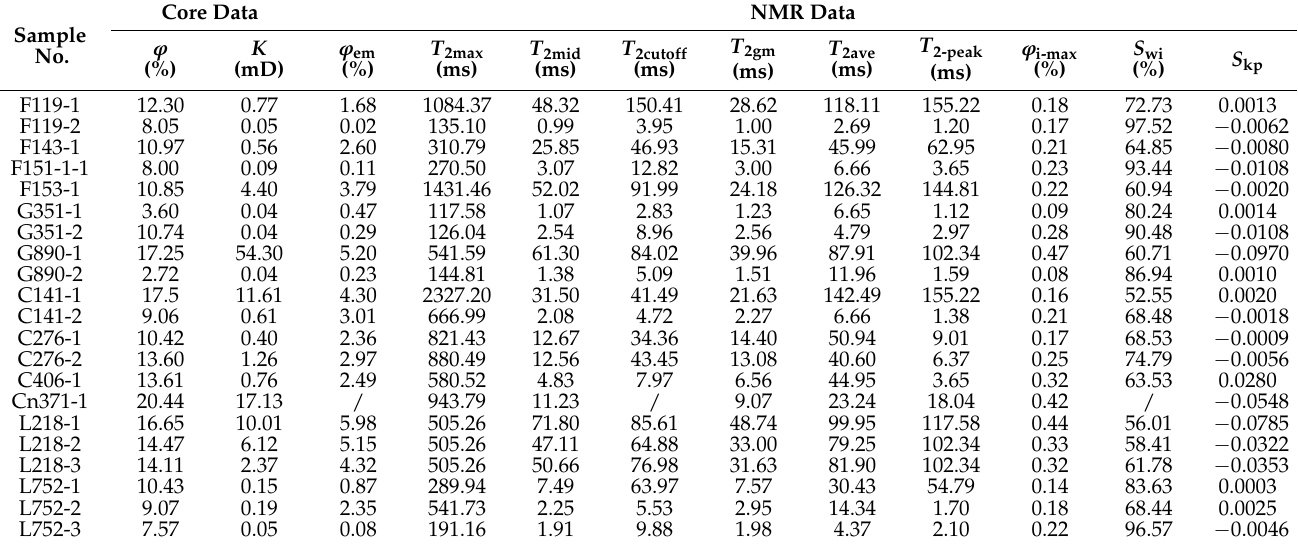
Table 1. NMR T 2 spectral parameters of 21 sandstone samples obtained by 100% water-saturated and centrifugal T 2 spectra. Sample Cn371-1 is not well consolidated, falling apart during the centrifugation experiment; thus, there is no centrifugation data for the sample. Sample